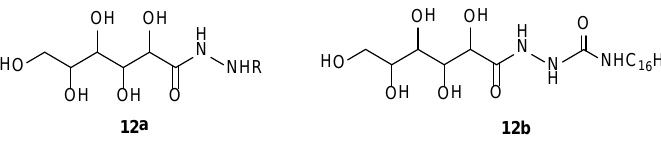
Figure 10. Gluconohydrazide 12a and gluconosemicarbazide 12b .